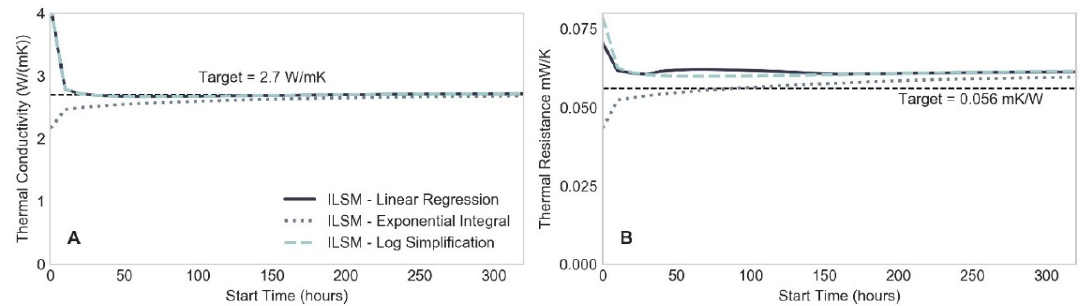
Figure 12. Step-wise fitting of the ILSM giving the change in ( A ) λ g and ( B ) R b over time for the Synthetic TRT data.